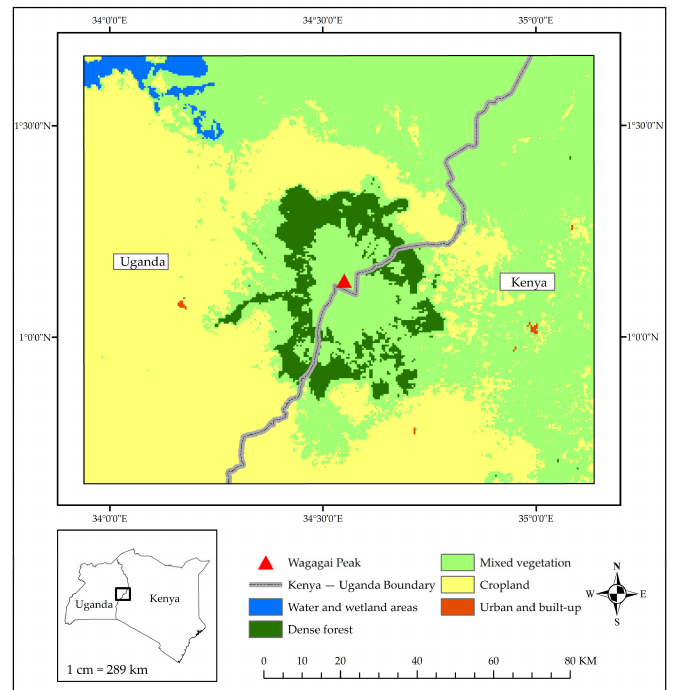
Figure 1. Mount Elgon ecosystem (MEE) land-use and land-cover (LULC) in 2018. This map was created by reclassifying Moderate Resolution Imaging Spectroradiometer (MODIS) land-cover data (MCD12Q1) created by the University of Maryland [36]. Mixed vegetation includes savanna, grasslands, and shrubs. Cropland includes cropland and the cropland-vegetation mosaic classes. The black-gray line represents the boundary between Kenya and Uganda and the red triangle is Wagagai Peak, the highest point on Mount Elgon (4321 m above sea